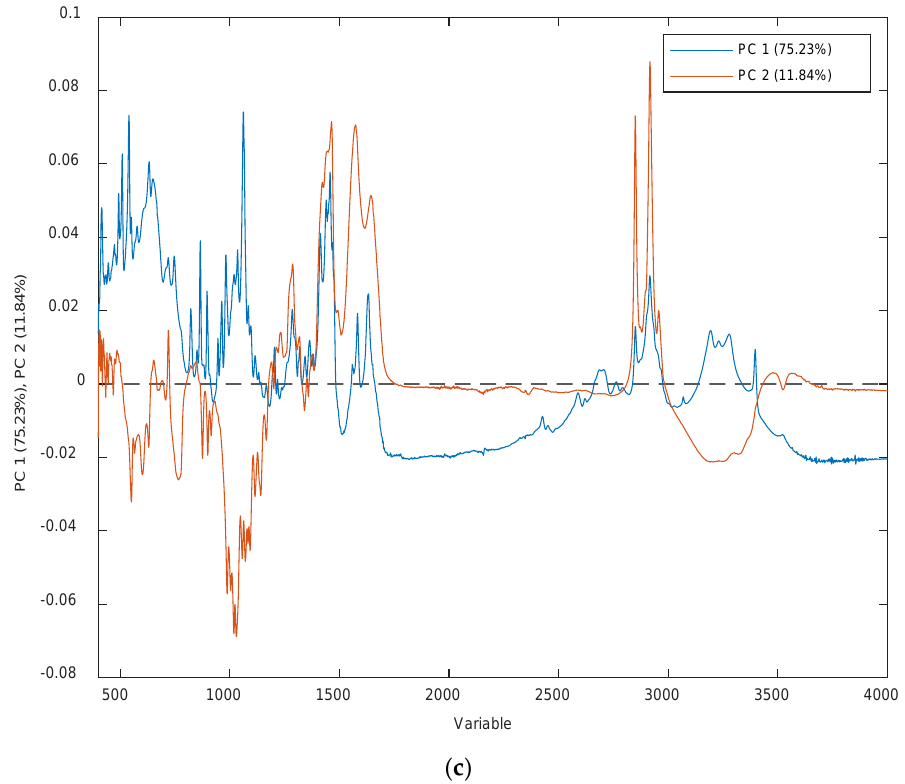
Figure 11. Principal component analysis ( a ) scores plot with samples distinguished as a function of the components; ( b ) scores plot with samples distinguished as a function of the ratio of the components; ( c ) loadings plot.